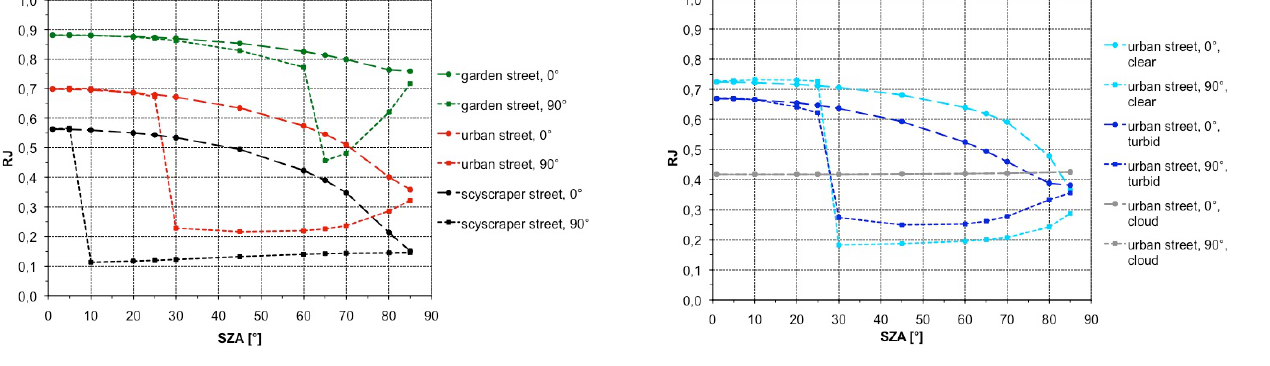
Fig. 6. Ratio RJ of NO 2 photolysis frequency in a street canyon and for undisturbed conditions as function of the solar zenith angle for a cloud-free atmosphere with average turbidity for three street types with street orientation parallel ( ϕ =0 ◦ ) and perpendicular to the sun ( ϕ =90 ◦ ).